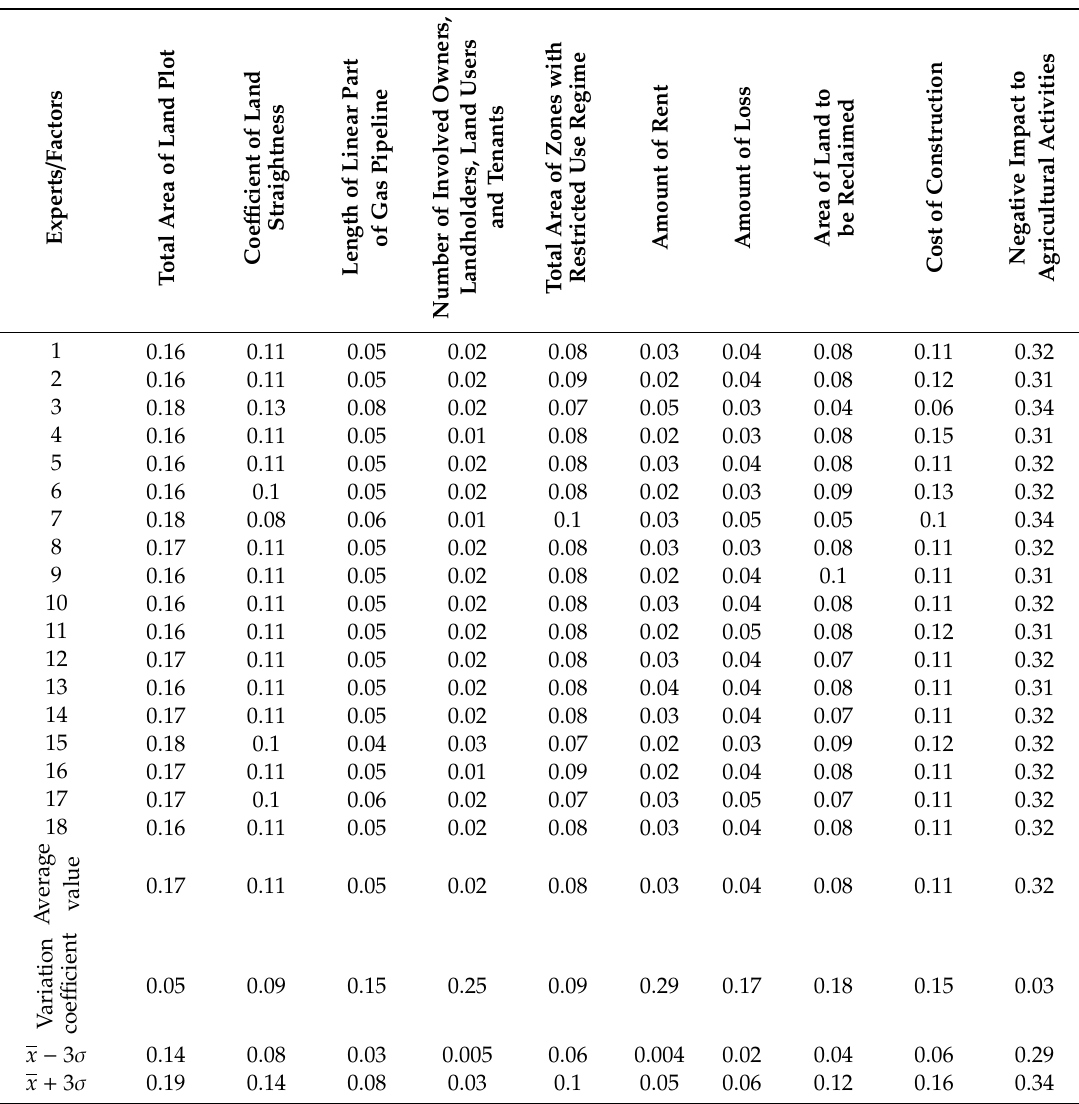
Table 3. Summary table of priority values of factors and consistency of expert evaluations.